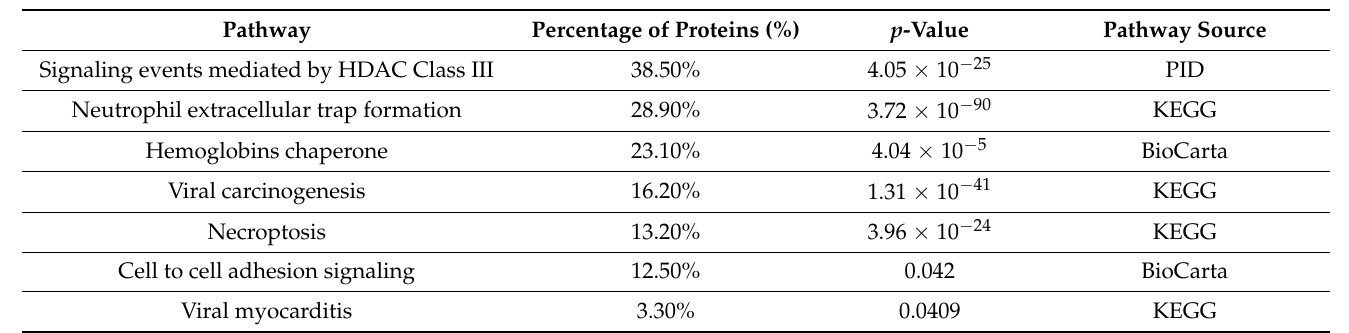
Table 3. Pathways involved in upregulated proteins in SCC vs. SIL group using ConsensusPathDB